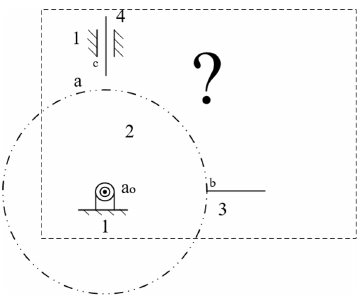
Figure 8. The waterwheel steelyard clepsydra device – model